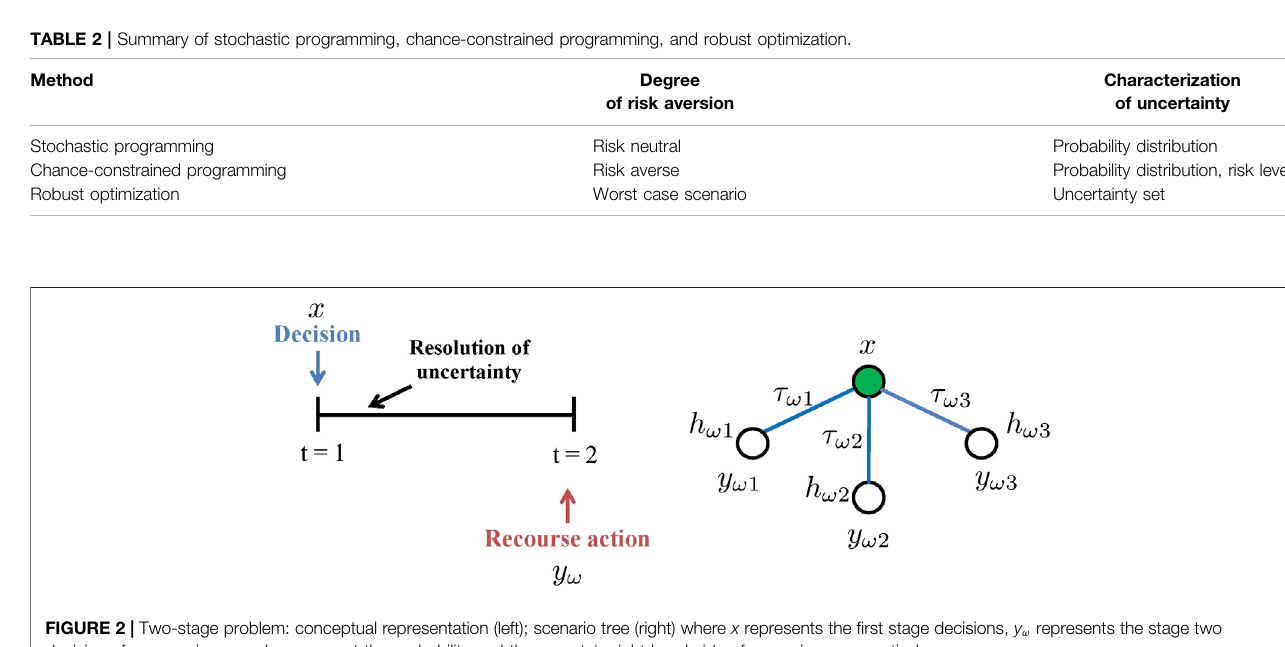
Frontiers in Chemical Engineering |